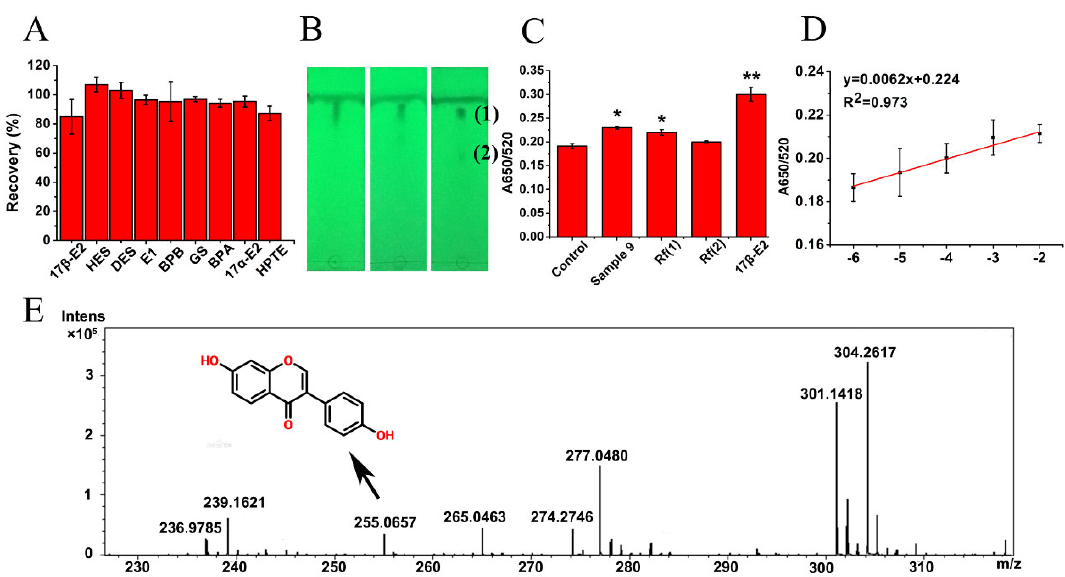
Figure 4. ( A ) The recovery results of milk spiked into nine EDCs analyzed by AuNPs-ER cocktail colorimetric assay. ( B ) The separation of unknown EDCs by TLC from dairy products. ( C ) Estrogenic activity of EDCs in dairy products demonstrated by AuNPs-ER cocktail colorimetric assay. (* indicate statistically significant differences between groups ( p < 0.05), n = 3, ** indicate statistically significant differences between groups ( p < 0.01), n = 3. ( D ) The standard curve of daidzein was obtained by AuNPs-ER cocktail colorimetric assay. ( E ) The mass spectrometry of unknown EDC substances with higher estrogenic activity isolated from dairy products.